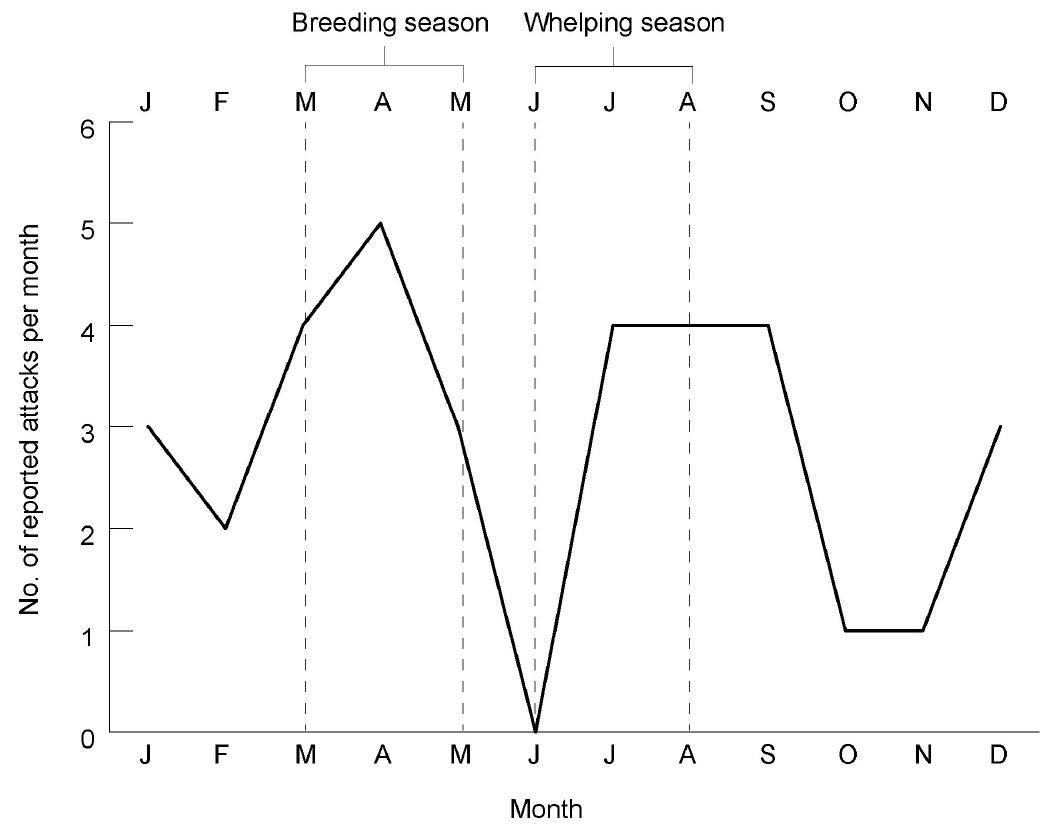
Figure 4. Seasonality of dingo attacks in historical accounts ( n = 34) for which the month of the incident is known. Data source: Table A1. Where a date range for an historical account was given (e.g., April to May, late April/early May), the first month was used (i.e.,